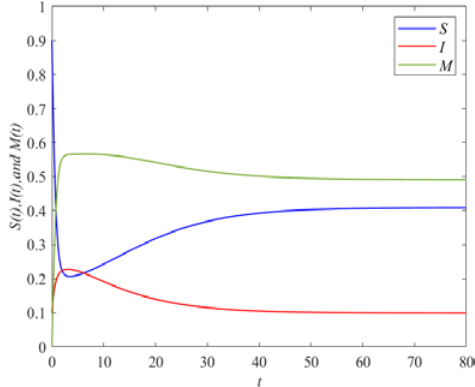
Fig. 2. Malware-free behavior of the model.